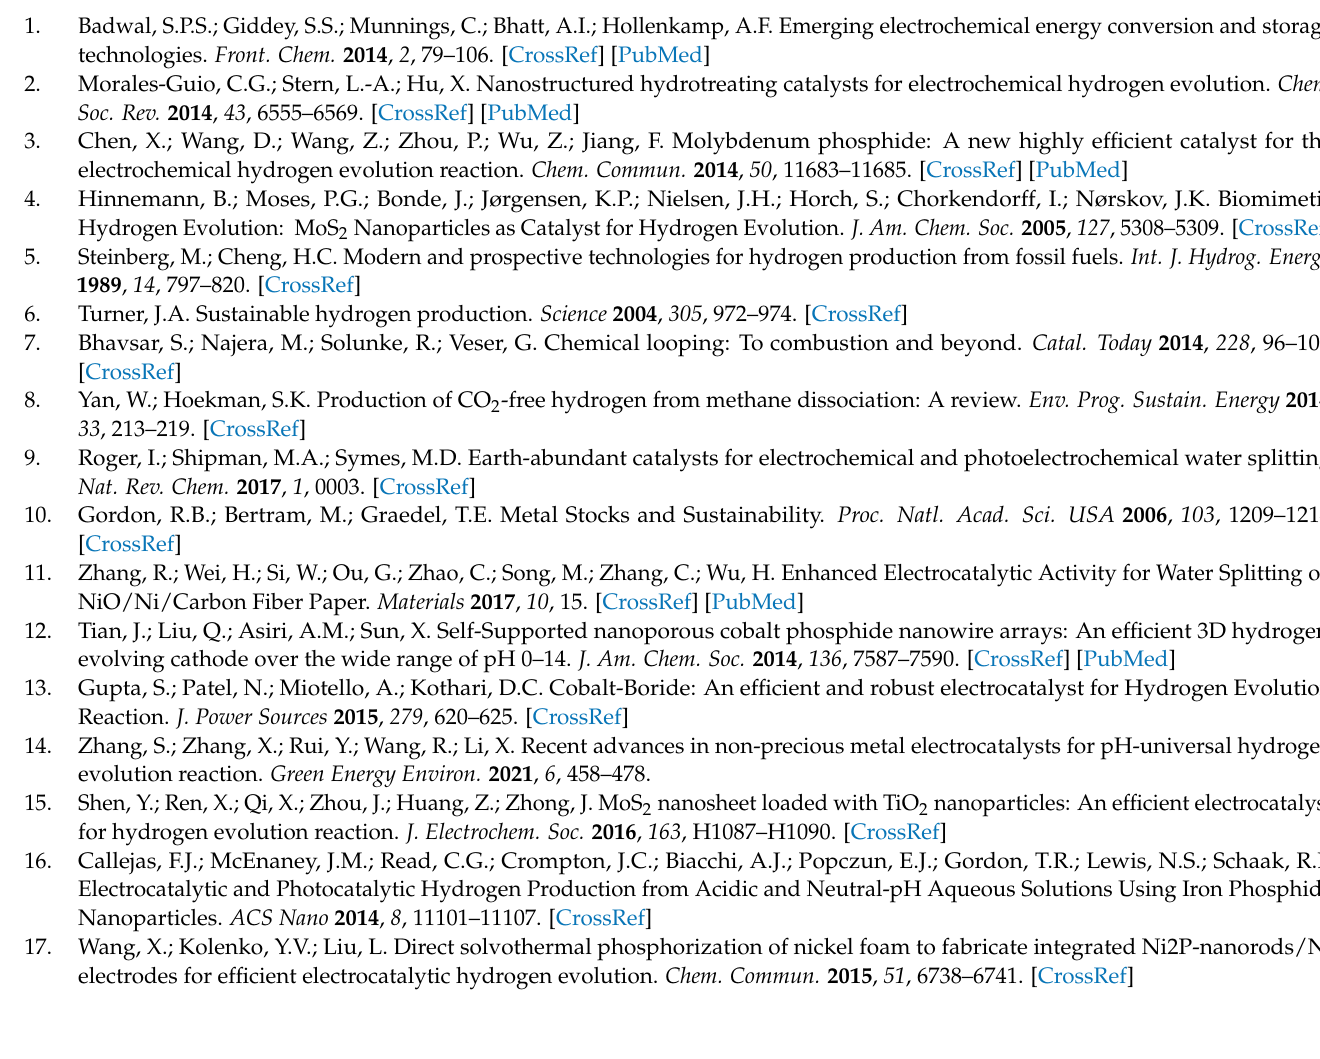
Figure S1: Complex-plane EIS plots for the bare GCE electrode (a) and Pt/C (b). Measurements were conducted in 0.1 M KOH at 500 mV at room temperature; Figure S2: Equivalent circuits used to fit the experimental impedance data; Table S2: Comparison of HER catalytic activity of our synthesized Zn3 and Zn3/GO electrocatalysts with the highly efficient electrocatalysts reported in the literature